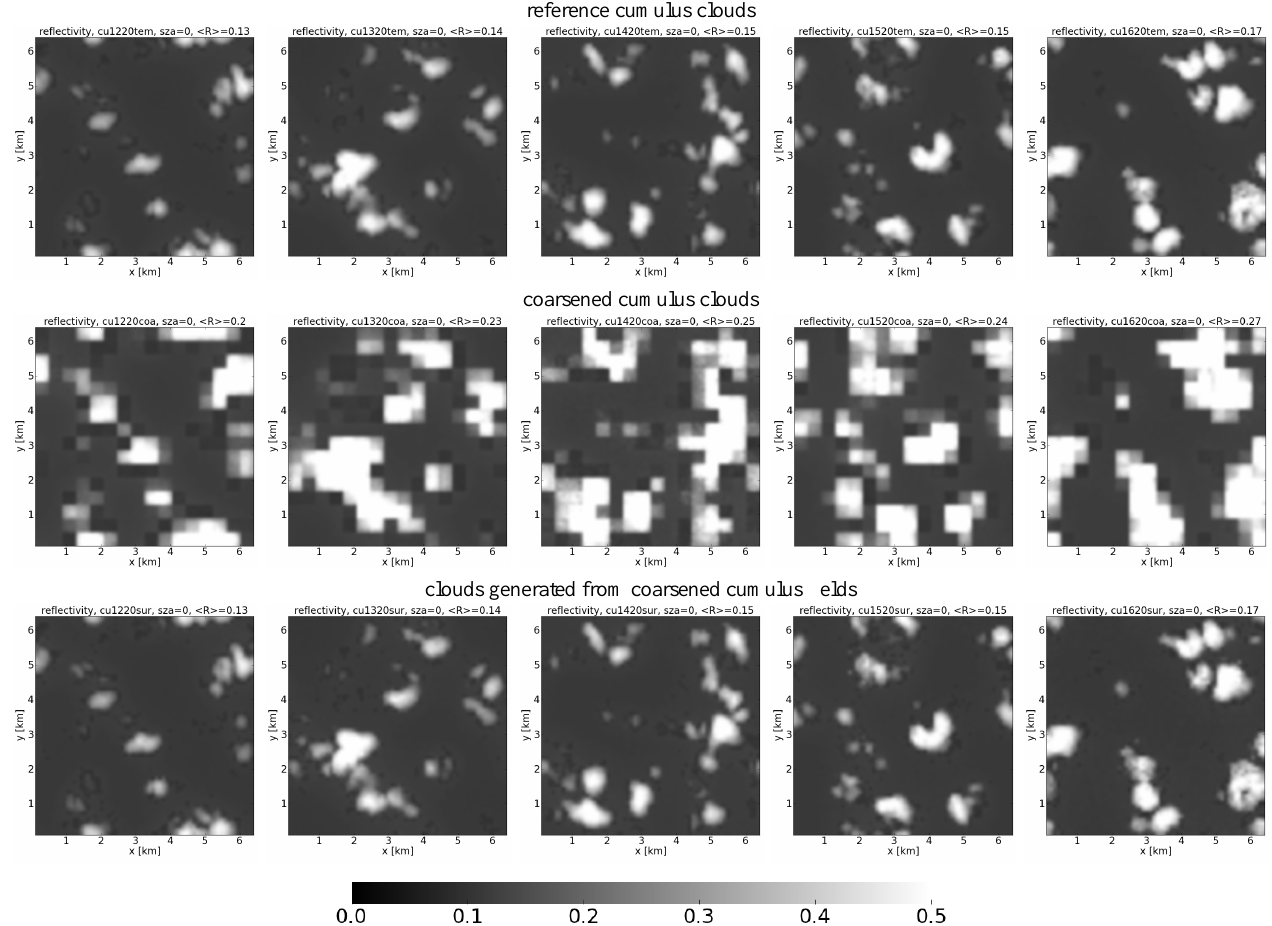
Fig. 4. Reflectivity fields of some selected scenes of the cumulus diurnal cycle presented in Sect. 3. The sun is overhead (SZA=0 ◦ ) and the observer looks exactly in the nadir direction. The top row corresponds to the LES clouds considered here as the reference (see Fig. 3). The middle row represents the coarsened cloud reflectivities. The bottom row illustrates the reflectivities calculated at clouds generated from the coarsened ones by adding the missing sub-scale variability. Notice the similarity of the top and bottom row fields indicating the good performance of the downscaling method.